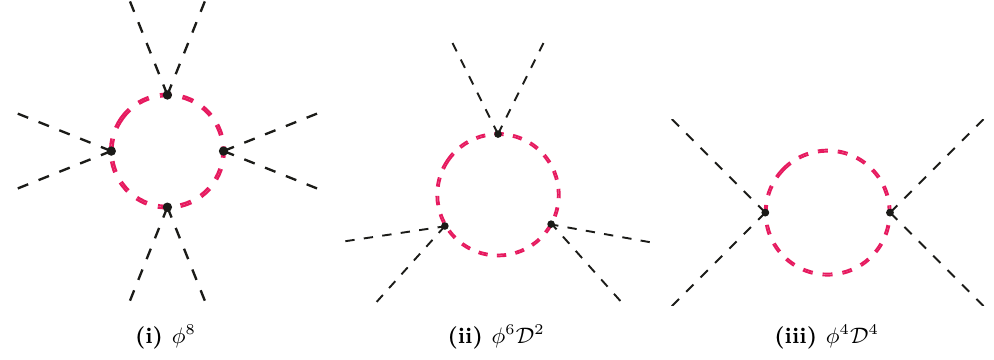
Figure 4. One-loop schematic diagrams revealing heavy scalar propagators enveloped within (i) φ 8 , (ii) φ 6 D 2 , and (iii) φ 4 D 4 classes of SMEFT operators.